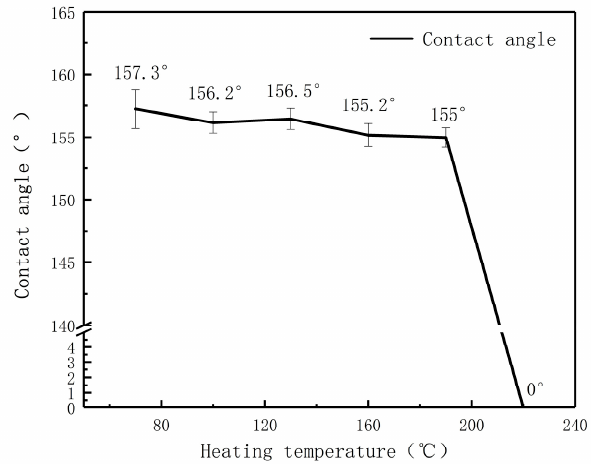
Figure 11. Thermal stability test of the SMA.